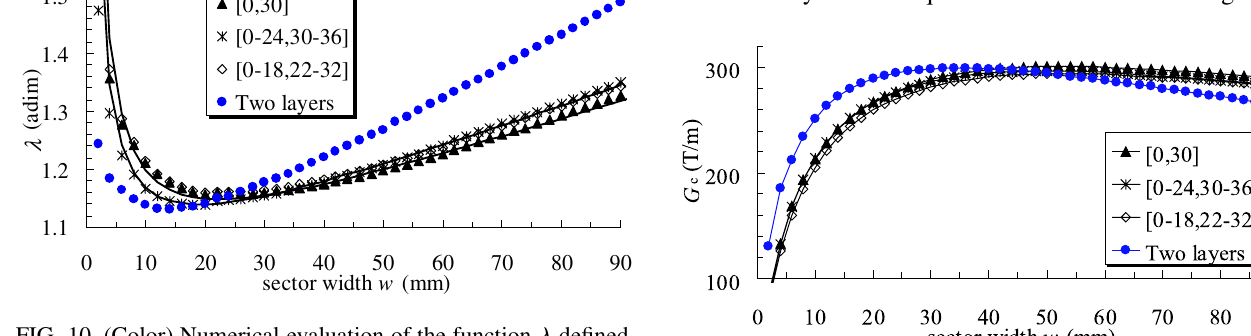
FIG. 10. (Color) Numerical evaluation of the function (cid:8) defined in Eq. (31) versus sector width for different sector layouts, aperture radius of 30 mm, and fitting curves as defined in (32) for the 0 (cid:9) , 30 (cid:9) and 0 (cid:9) –24 (cid:9) , 30 (cid:9) –36 (cid:9) design.